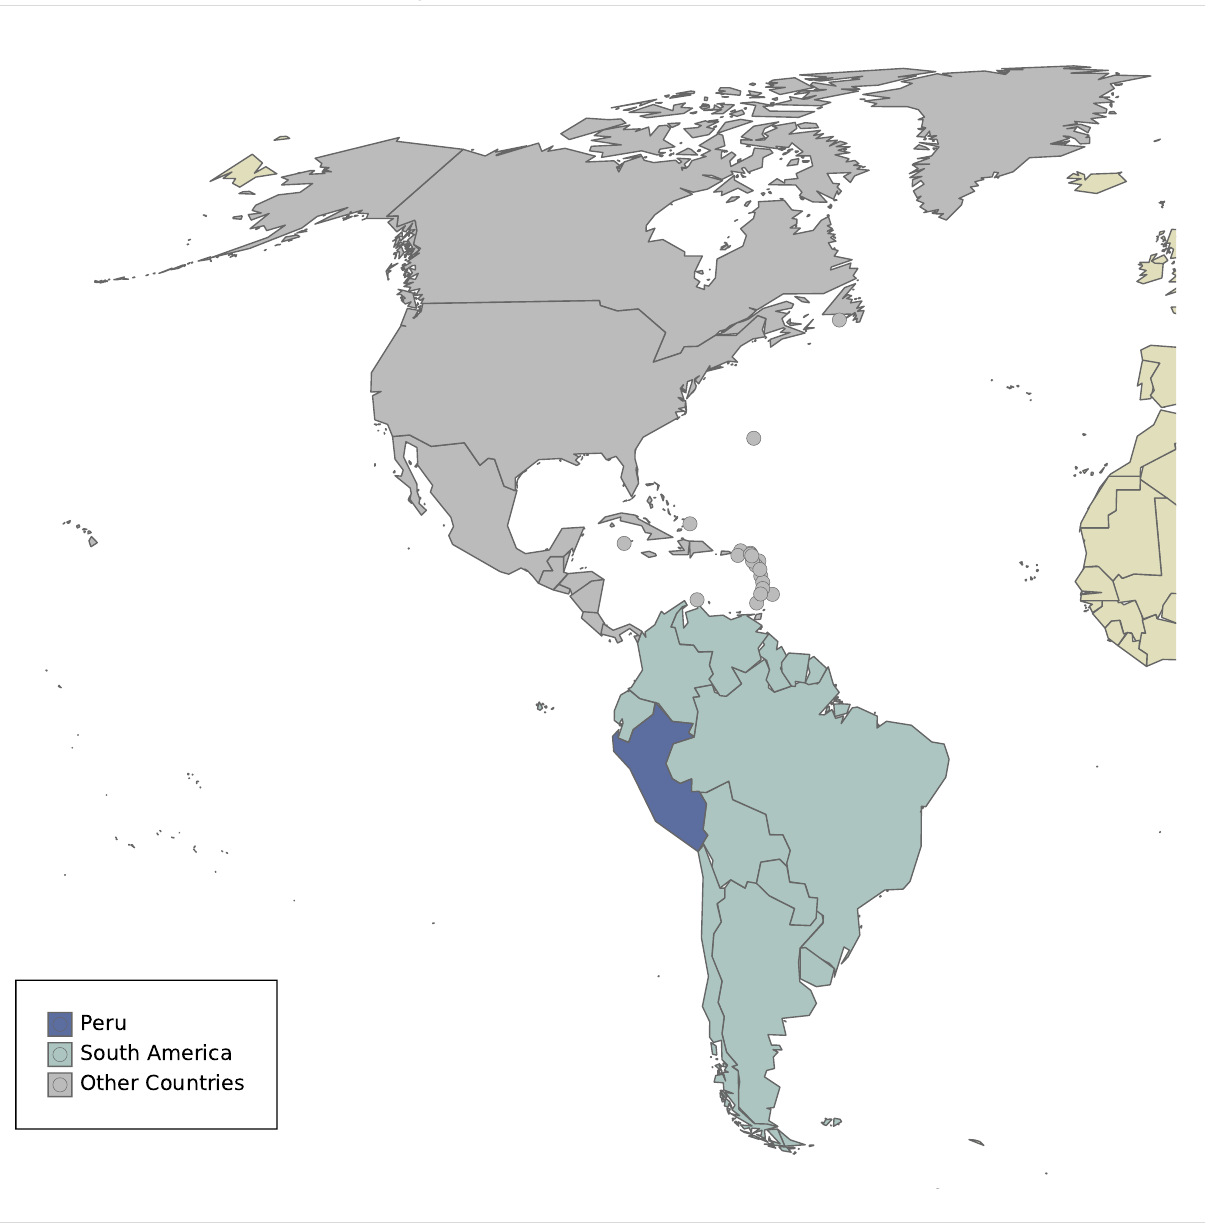
Figure 1: Peru and South